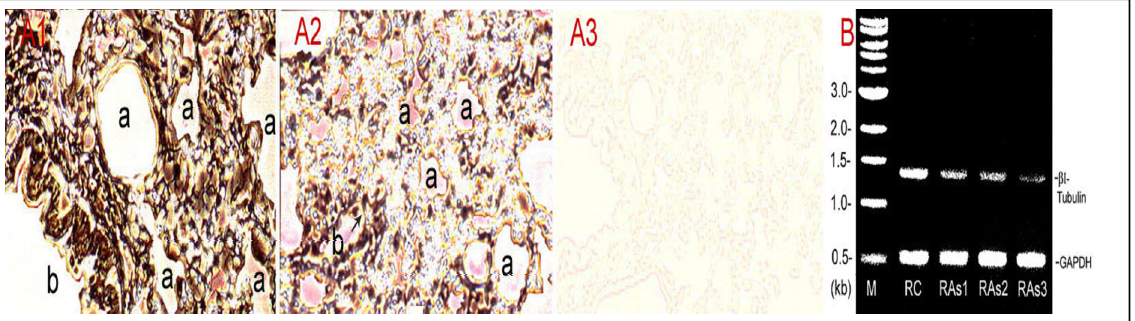
Figure 4. Inhibition of β -tubulin expression at protein and mRNA levels in As 3+